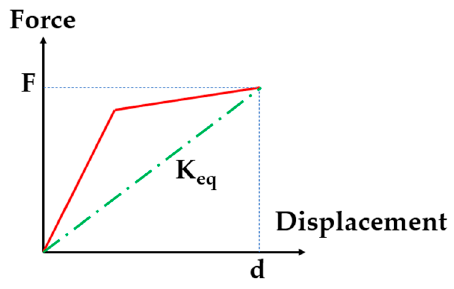
Figure 12. Definition of effective stiffness. Red line is the bi-linear relationship between force and displacement, while the green dash line is the equivalent stiffness. Table 3. Calculated shear moduli of the proposed model under monotonic and cyclic loading at the target shear stain.